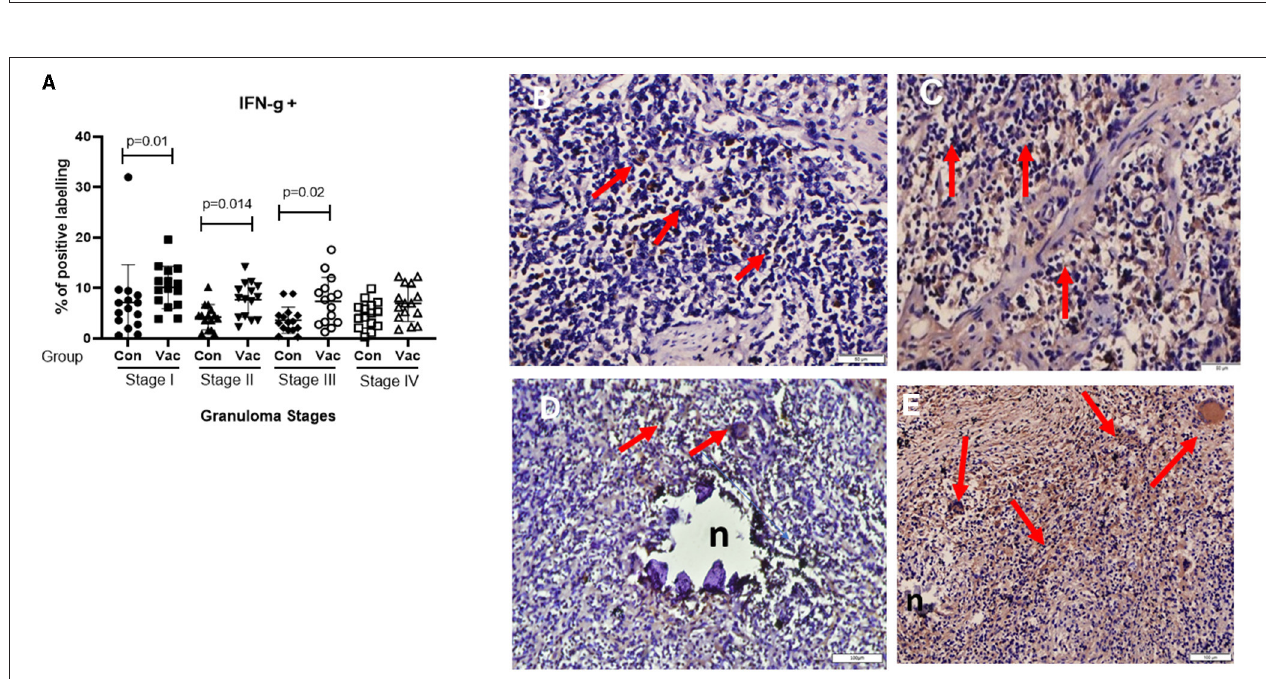
FIGURE 5 | Immunolabelling for IFN- γ + . (A) Comparison of IFN- γ + cell distribution in different granuloma stages of BCG vaccinated (Vac) and non-vaccinated (Con) calves. (B) Stage I granuloma from non-vaccinated calf with some IFN- γ + positively stained cells (arrows). (C) Stage I granuloma from BCG vaccinated calf has more lymphocytes stained for IFN- γ + (arrows). (D) Stage IV granuloma showing IFN- γ + stained cells from non-vaccinated calf (arrows). (E) Stage IV granuloma showing IFN- γ + stained cells from BCG vaccinated calf (arrows). 50 µ m for (B,C) , Bar equals 100 µ m in (D,E) .